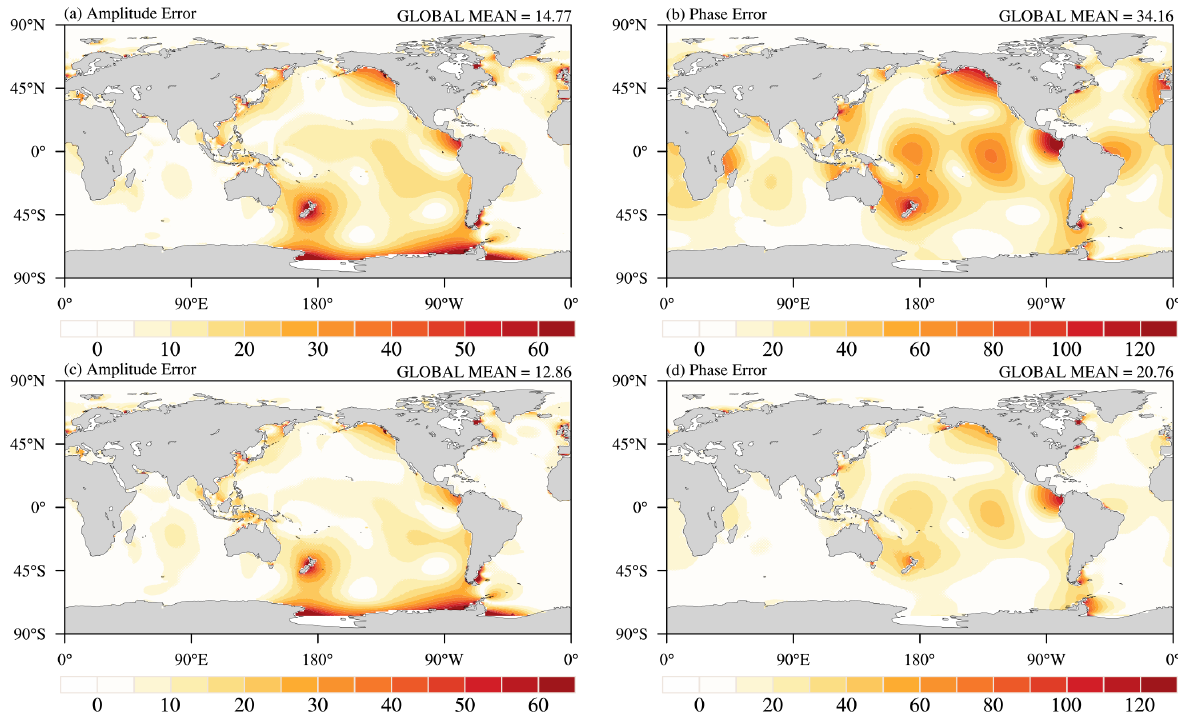
Figure 7. The contributions to the total error of M2 resulting from errors in (a) tidal amplitude and (b) phase for Exp1; (c) and (d) are the same, but for Exp2. The units are centimeters. Table 1. Global mean values of the amplitudes of the eight tidal constituents during observation, Exp1, and Exp2, and the amplitude, phase, and total errors of the eight tidal constituents in Exp1 and Exp2. The units are centimeters. The better amplitude and lower errors in Exp2 relative to Exp1 are marked in bold. Global